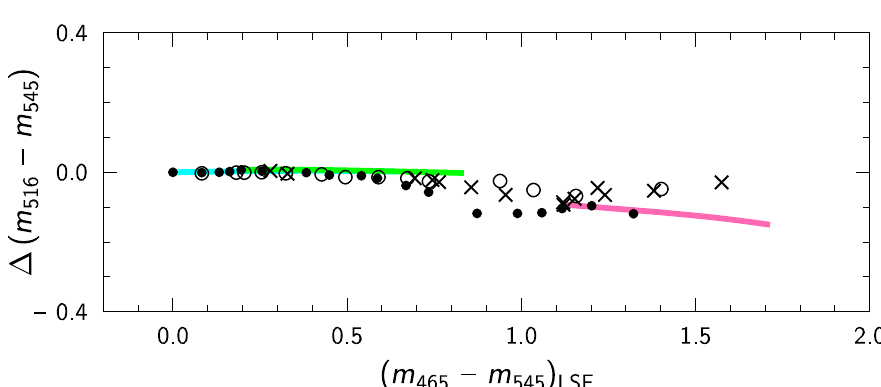
Fig. 8d. The same as in Figure 8a but for the color index m 465 – m 545 .